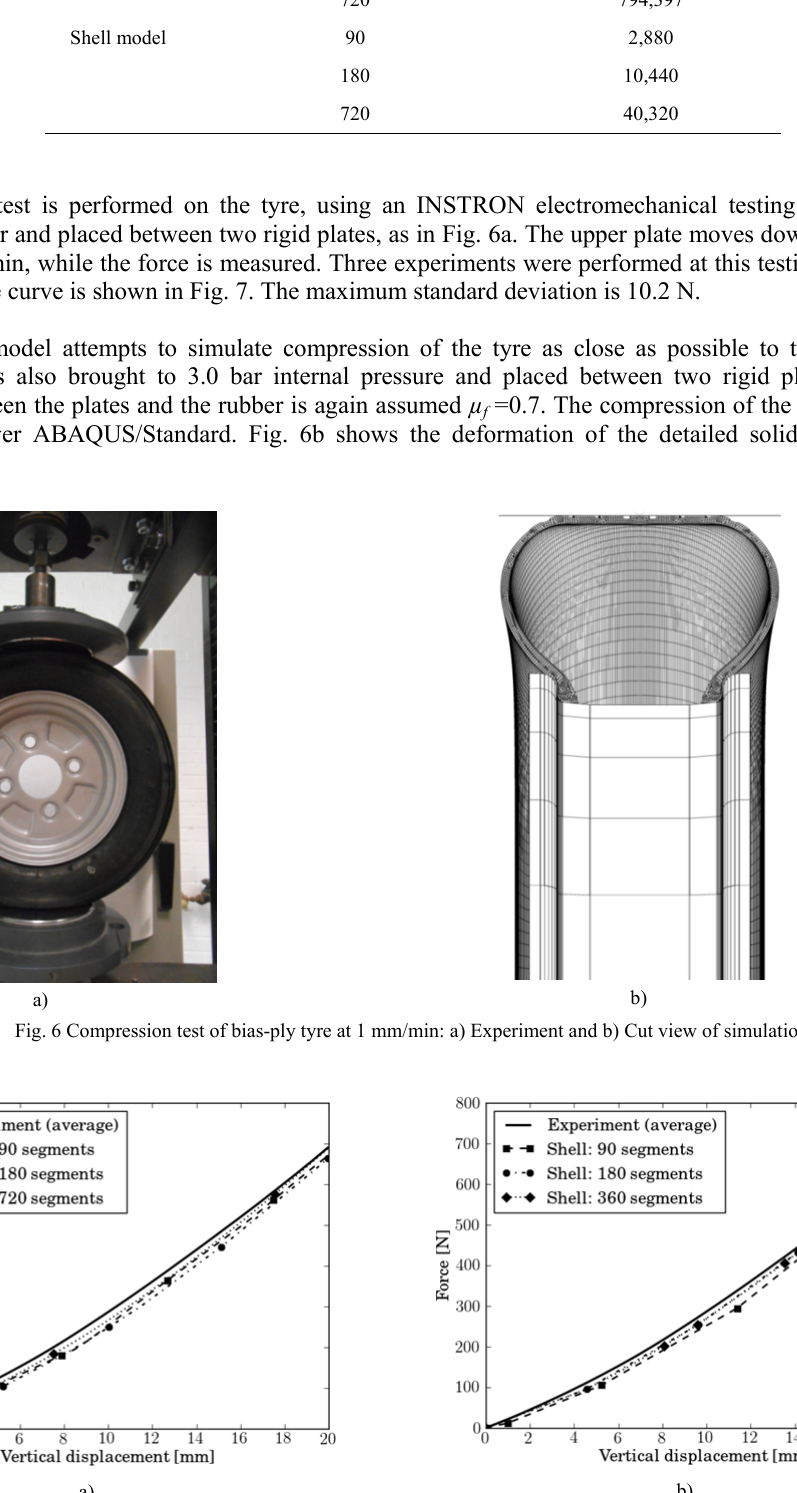
Fig. 7 Force vs. displacement for compression test of the bias-ply tyre: mean experimental curve and simulated results for a) Solid models and b) Shell